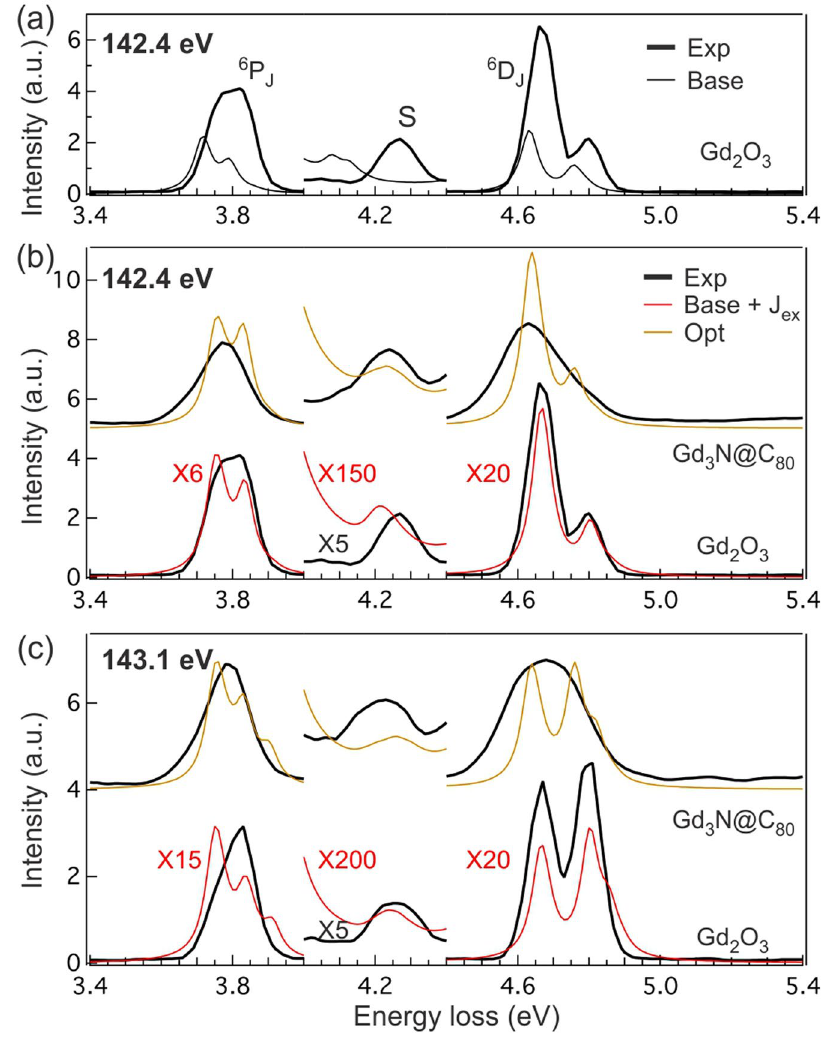
Figure 3. ( a ) Comparison of Gd 2 O 3 (thick black line) and simulated Gd 3 + (baseline; thin black line) RIXS spectra at 142.4 eV excitation photon energy. The simulation parameters for baseline spectrum are listed in Table 1. ( b , c ) Comparison of Gd 3 N@C 80 (thick black line) and simulated RIXS spectra (thin yellow line) with optimized energy parameters (1% reduction in 4 f –4 f Coulomb interactions, 10% reduction in SOC, and J ex = 40 meV; parameters are listed in Table 1) at excitation photon energy of ( b ) 142.4 eV and ( c ) 143.1 eV. The experimental Gd 2 O 3 RIXS spectra (thick black line) and baseline simulations plus J ex = 30 meV (thin red line) are also shown in the bottom part of the same figures. For comparison, spectra are scaled differently in different energy windows. For 142.4 (143.1) eV excitation energy, the simulation is scaled up by a factor of 6 (15) in [3.4 eV, 4.0 eV] window; in [4.0 eV, 4.4 eV] window, the simulation and experiment are scaled up by a factor of 150 (200) and 5 (5), respectively; in [4.4 eV, 5.4 eV] window, the simulation is scaled up by a factor of 20 (20). The scaling factors (red for simulations and black for experiments) are also listed in the